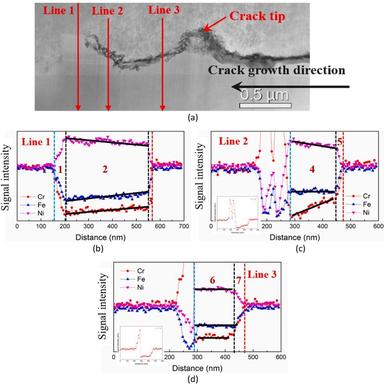
(a) HAADF image showing a representative SCC crack tip prepared from Fe-16Cr-60Ni alloy with indication of EELS line-scan positions; signal intensity line profiles obtained through EELS analysis performed at the positions of (b) Line 1, (c) Line 2, and (d) Line 3.